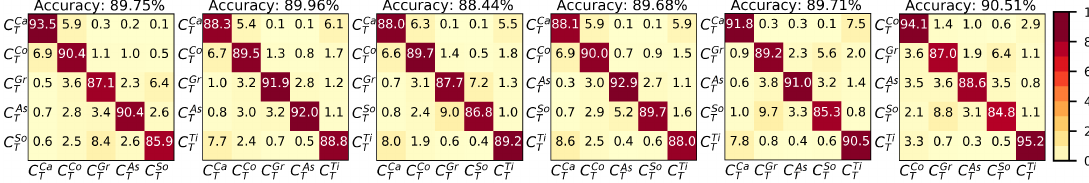
= carpet , C Co = concrete , T T